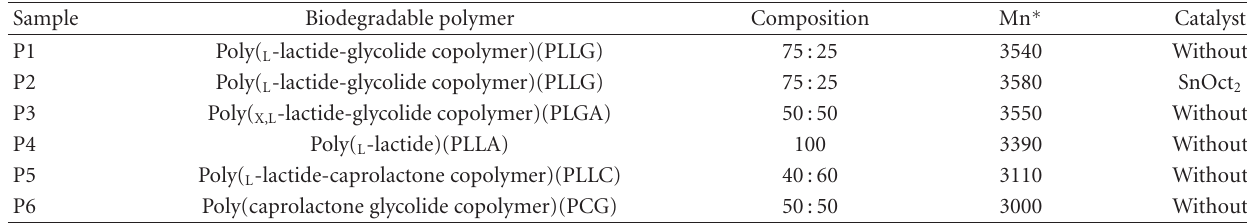
Table 1: Condition and composition of biodegradable polymers.